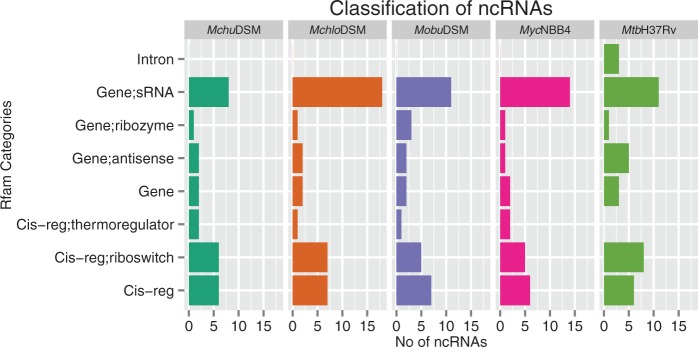
Functional classification of noncoding RNA (ncRNAs). Classification of noncoding RNAs in the MchloDSM, MchuDSM, MobuDSM, and MycNBB4 strains, for details see the main text.